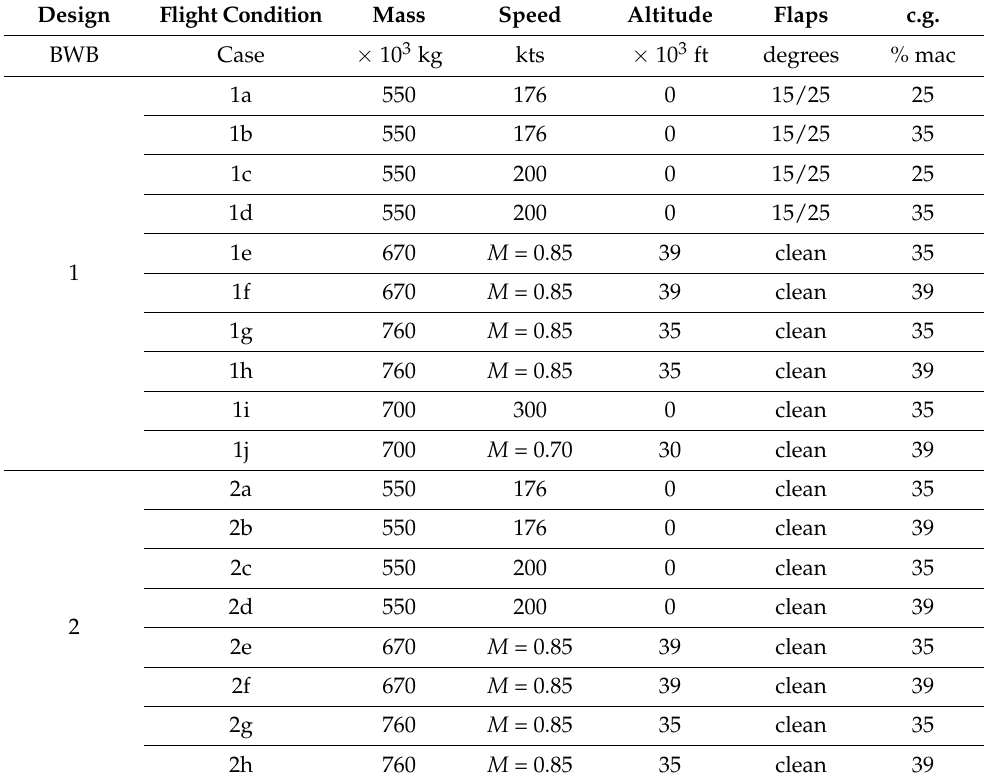
Table 3. Flying-wing flight